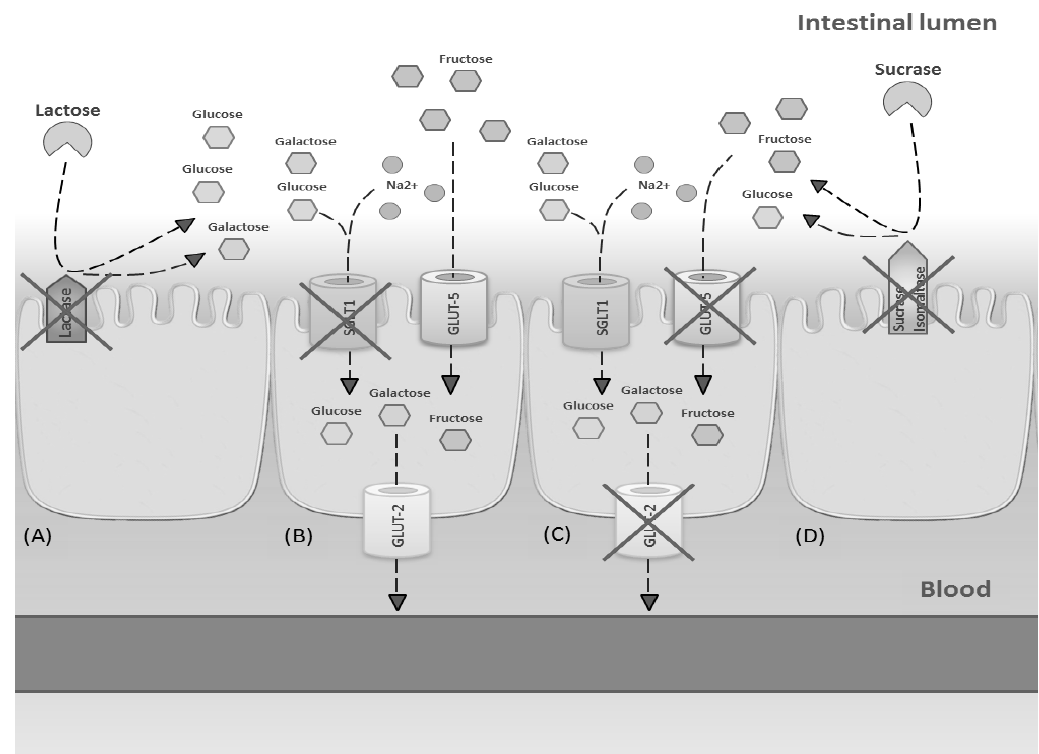
Figure 3. Mechanisms involved in main carbohydrate intolerances. ( A ) Lactose intolerance due to deficiency of lactase enzyme; ( B ) glucose ‐ galactose malabsorption due to a genetic defect in SGLT1 expression; ( C ) fructose malabsorption due to dose ‐ dependent transporters overloading; ( D ) sucrase malabsorption due to a genetic defect in sucrase ‐ isomaltase activity.